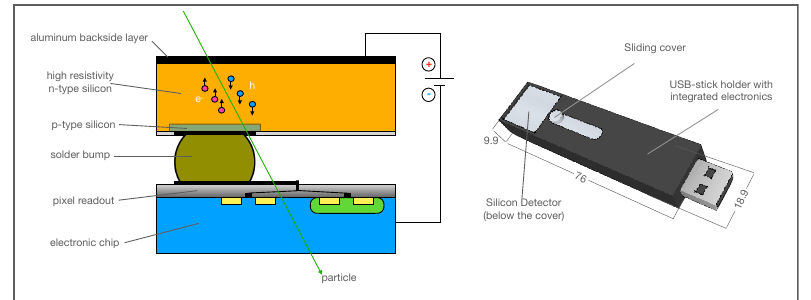
Figure 1. Left Canvas: the sketch shows the vertical cross-section of the Timepix detector. The p-type superficial implantation on the n-type semiconductor creates a local depletion zone corresponding to the single pixel. The pixel is then connected to the ASIC read-out chip through a solder bump. Right Canvas: Sketch of the TimePix detector. The dimensions are in